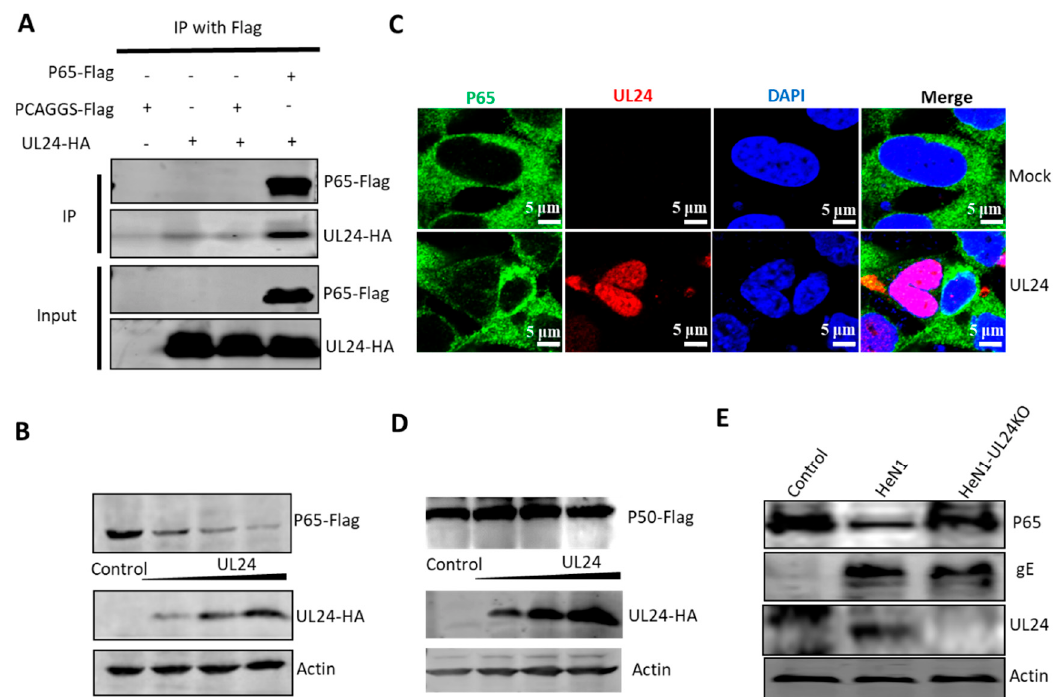
Figure 4. UL24 interacts with p65 and leads to its degradation. ( A ) HEK293T cells were co-transfected with a p65-Flag expression plasmid and a UL24-HA expression plasmid for 48 h. The cells were lysed, and the extracts were processed for immunoprecipitation with an anti-Flag antibody. Precipitated proteins and whole-cell lysates were probed with antibodies against HA and Flag. ( B ) HEK293T cells were co-transfected with increasing amounts of the UL24 plasmid (0, 0.5, 1, and 2 µg) and 2 µg of the p65 plasmid; the cells were lysed at 48 h post transfection, and the expression of p65 was detected by WB. ( C ) HEK293T cells were transfected with 2 µg of UL24-HA expression plasmid. At 48 h post transfection, the P65 status of the cells was detected by immunofluorescence, scale bar was 5 µm. ( D ) HEK293T cells were co-transfected with increasing amounts of the UL24 plasmid (0, 0.5, 1, and 2 µg) and 2 µ g of the p50 plasmid; the cells were detected by WB. ( E ) HEK293T cells were infected with wild-type PRV or UL24 knockout PRV at an MOI of 0.01 for 48 h. The cells were lysed, and the extracts were subjected to WB. The experiment was performed three times, and a representative result is